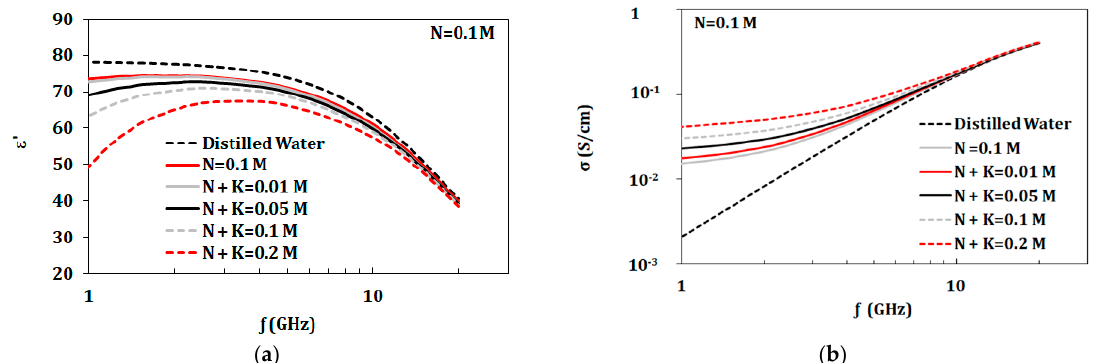
Figure 5. Measured dielectric properties for KCl solutions at ion concentrations from 0.01 to 0.2 mol/L and NaCl with fixed concentration of 0.1 mol/L at temperature 23 °C in the range of 1–20 GHz: ( a ) dielectric constant and ( b ) conductivity (“M” refers to mol/L).